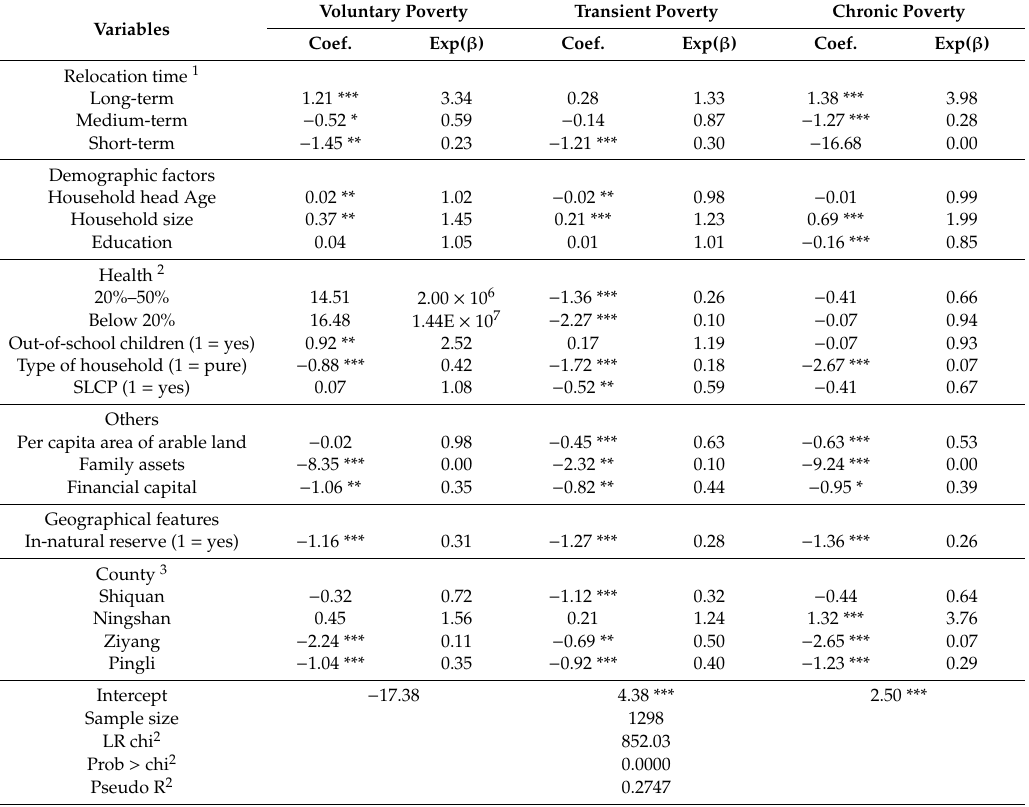
Table 3. Multinomial logistic model regression results of relocation